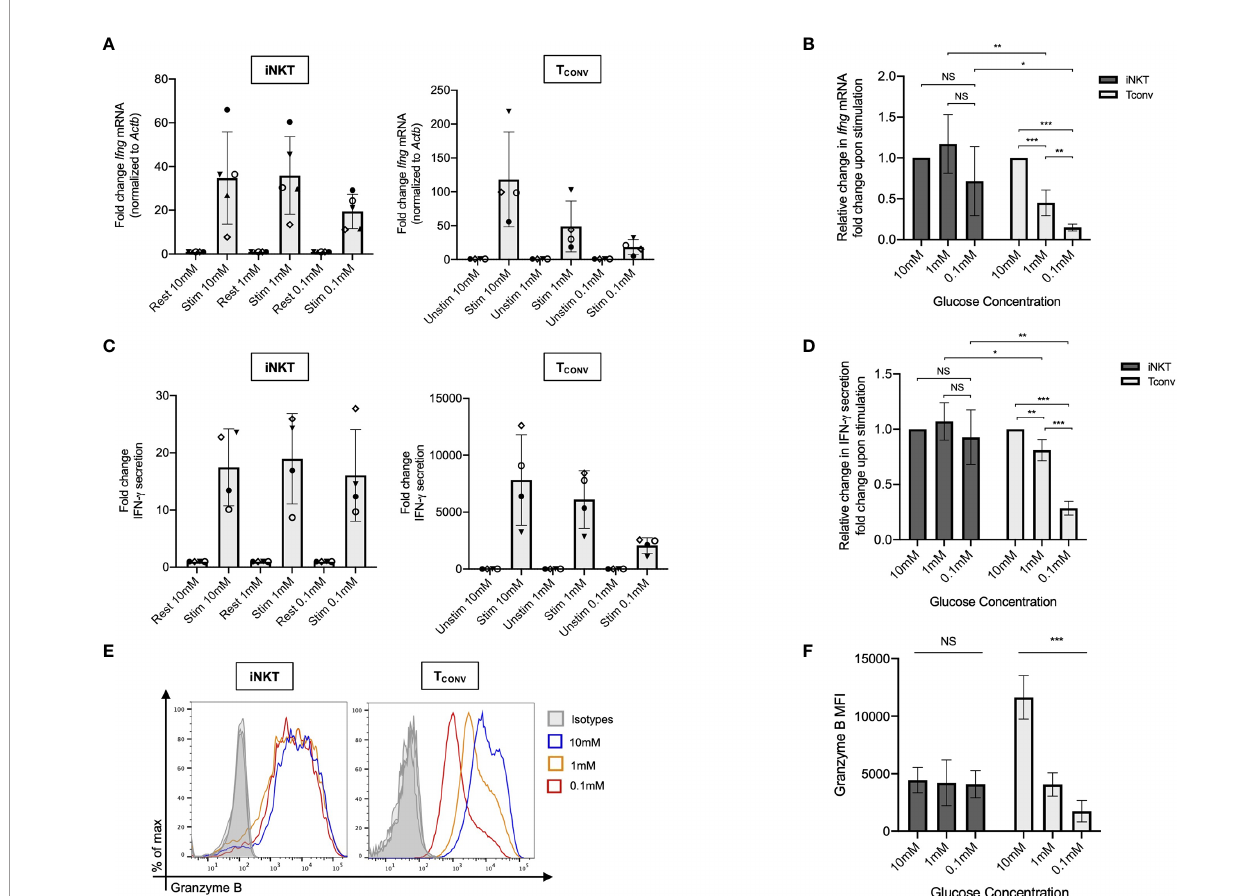
FIGURE 1 | Human iNKT cells do not depend on glucose for effector functions relative to T CONV . Sorted PBMC-derived iNKT cells and T CONV were rested or stimulated in RPMI media containing 10mM, 1mM, or 0.1mM glucose for 48 hours per schematic in Supplementary Figure 1 . (A) mRNA expression of Ifng was determined for iNKT cells (left) and T CONV (right) at 48 hours by qPCR (with values normalized to Actb expression). Fold change induction of Ifng upon stimulation relative to rest (iNKT) and unstimulated (T CONV ) conditions displayed. Each symbol represents matched, independent human donor biological replicates. (B) Summary data depicting fold change in Ifng Ct values upon stimulation from qPCR in (A) , relative to 10mM glucose, for iNKT and T CONV (C) Supernatants were collected from rested and stimulated iNKT cells (left) and T CONV (right) after 48 hours. IFN- g levels were detected via ELISA and fold change upregulation upon stimulation relative to rest (iNKT) and unstimulated (T CONV ) conditions displayed. Each symbol represents matched, independent human donor biological replicates. (D) Summary data depicting fold change in IFN- g secretion upon stimulation from ELISA in (C) , relative to 10mM glucose, for iNKT and T CONV. (E) Rested and stimulated iNKT cells and T CONV from matched human donors were stained for intracellular Granzyme B or isotype control; histogram of live, stimulated iNKT cells and T CONV representative of 4 matched, independent human donor samples. (F) Quanti fi cation of granzyme B mean fl uorescence intensity (MFI) of stimulated iNKT cells and T CONV normalized to isotype MFI indicated in bar graph. In all graphs, asterisks denote statistical signi fi cance (NS, non-signi fi cant; *p < 0.05, **p < 0.01, ***p < 0.001) determined by unpaired, two-way student ’ s t tests in (B, D) and simple linear regression test in (F) . For all studies, biological replicates of human donor samples are indicated by symbols, and n=4 technical replicates were performed. Each biological replicate of matched donor cells was run in independent